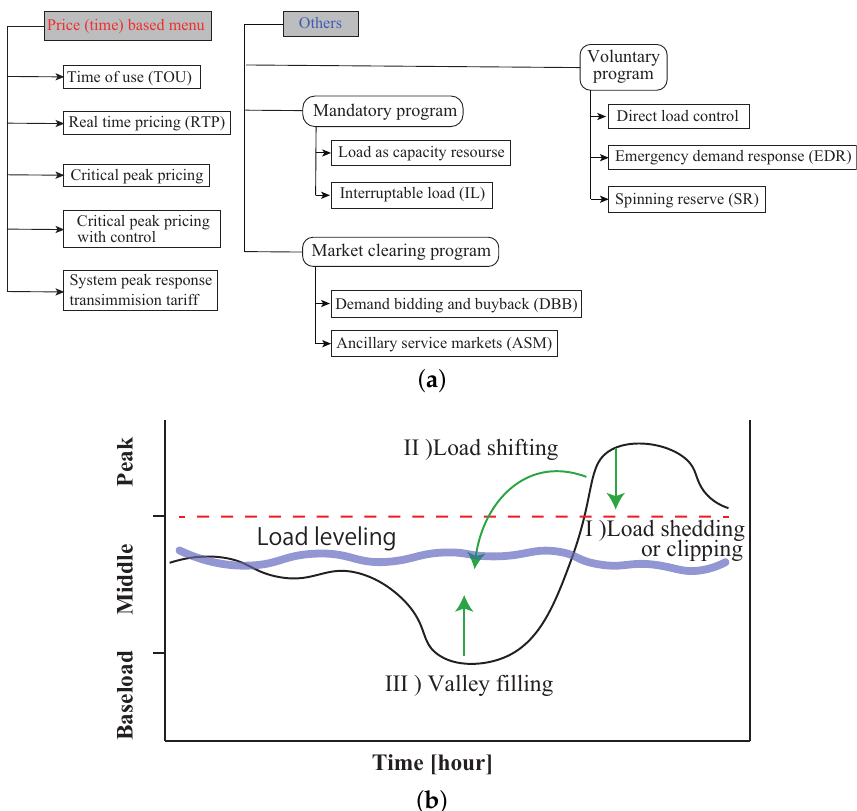
Figure 1. DR menu and its behavior. ( a ) Several DR menus regarding pricing based and others [35] and ( b ) an example of net load demand behavior under the DR